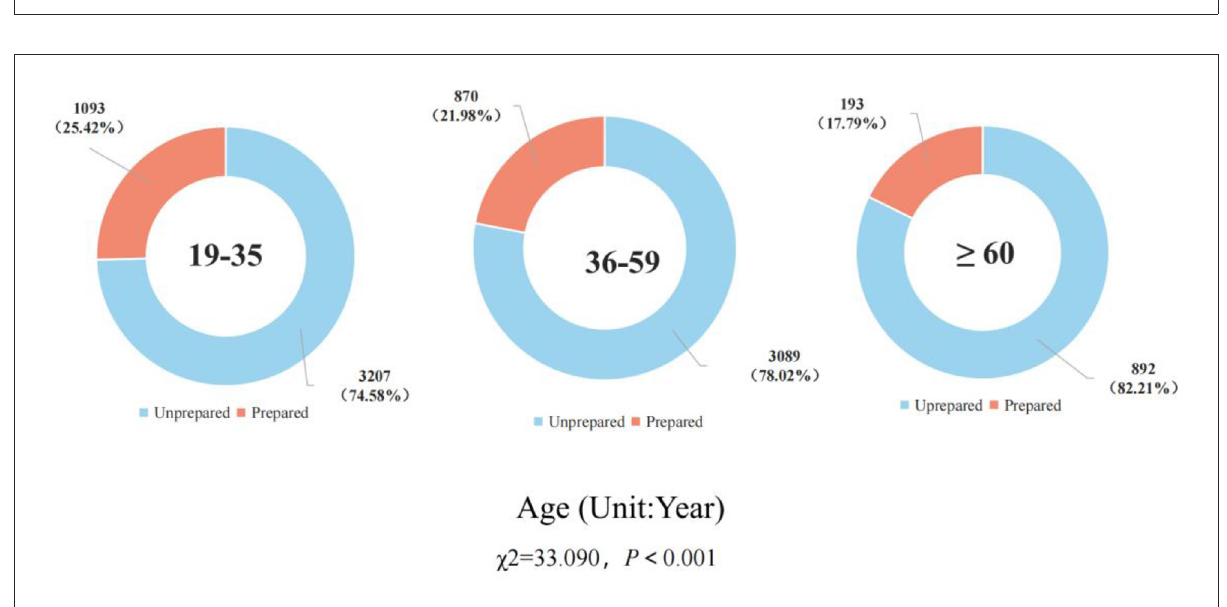
FIGURE3 Preparation of home first-aid kit by different age